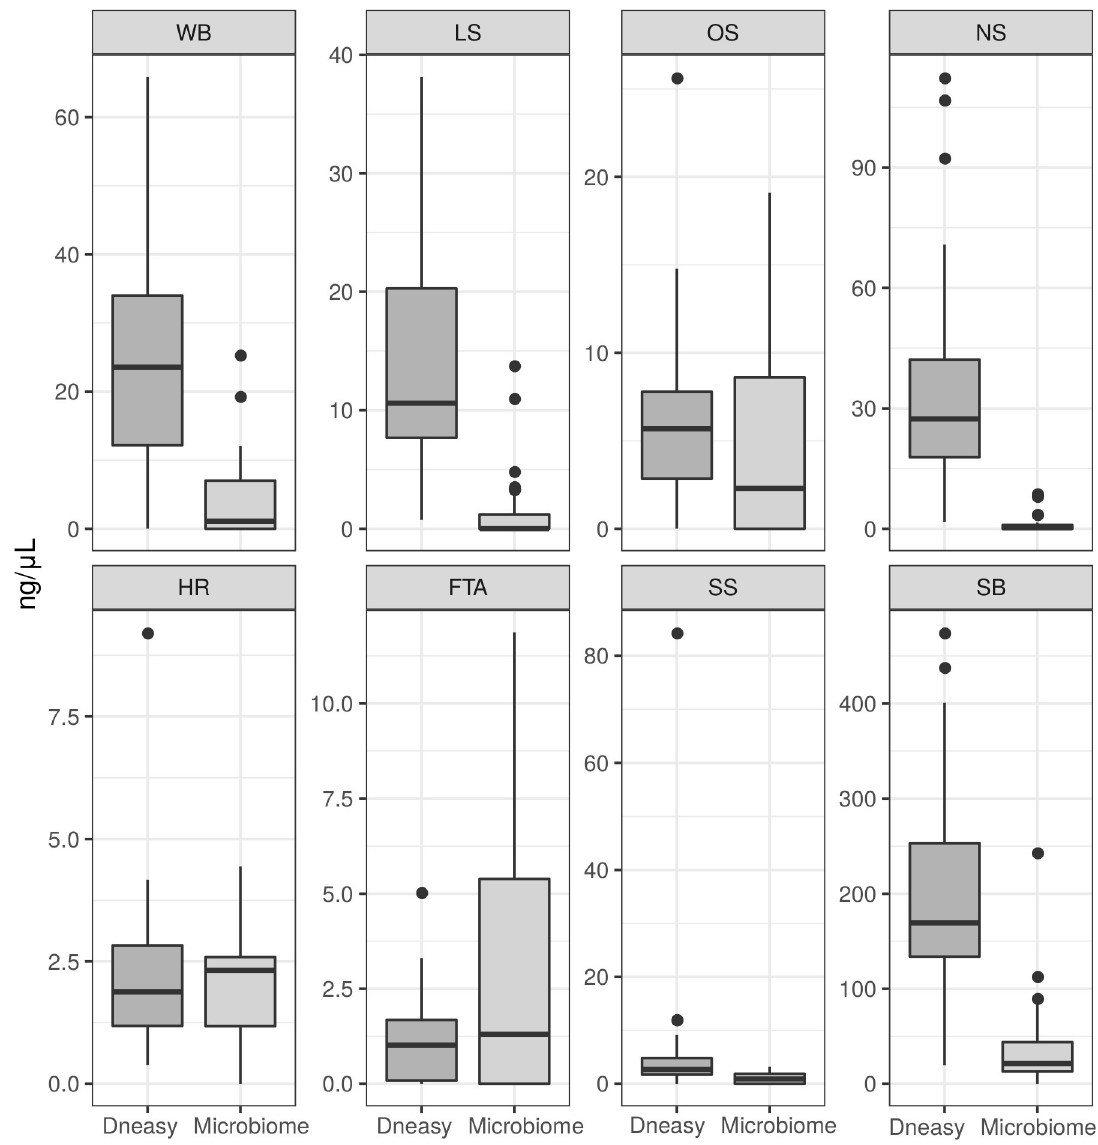
Fig 5. Total DNA yields from patient samples extracted by two different methods. Raw data displayed from spectrophotometer quantification. Boxplots show median, first quartile, third quartile, whiskers (1 st or 3 rd quartiles ± 1.5 × IQR) and outliers. SB, skin biopsy; SS, skin scraping; NS, nasal swab; HR, body hair; FTA, blood on FTA paper; LS, skin lesion swab; WB, whole blood; OS, oral swab; MB, multibacillary leprosy; PB, paucibacillary leprosy.